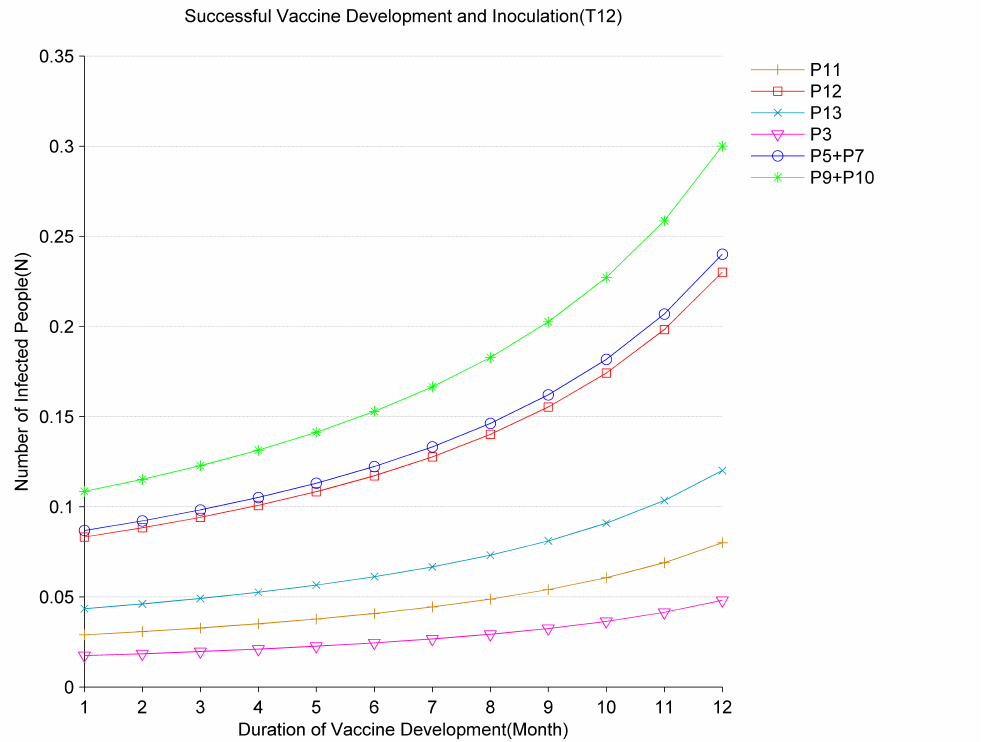
Figure 10. Relationship between duration of vaccine development and the number of infected